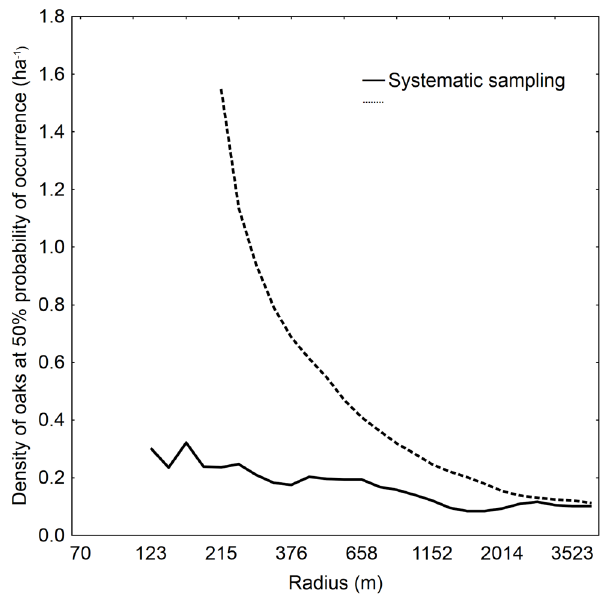
Figure 8. Model outcomes based on systematic sampling vs. strategic sampling. Smaller radii were excluded as such models